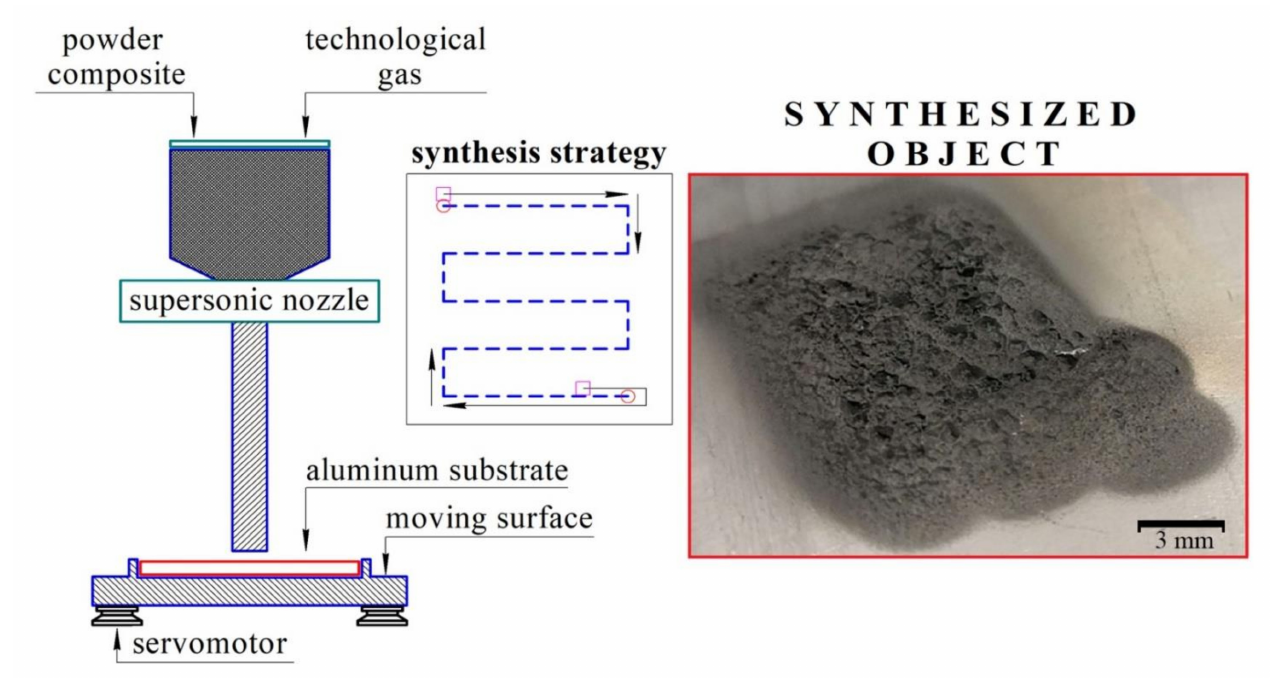
Figure 1. DIMET cold spray